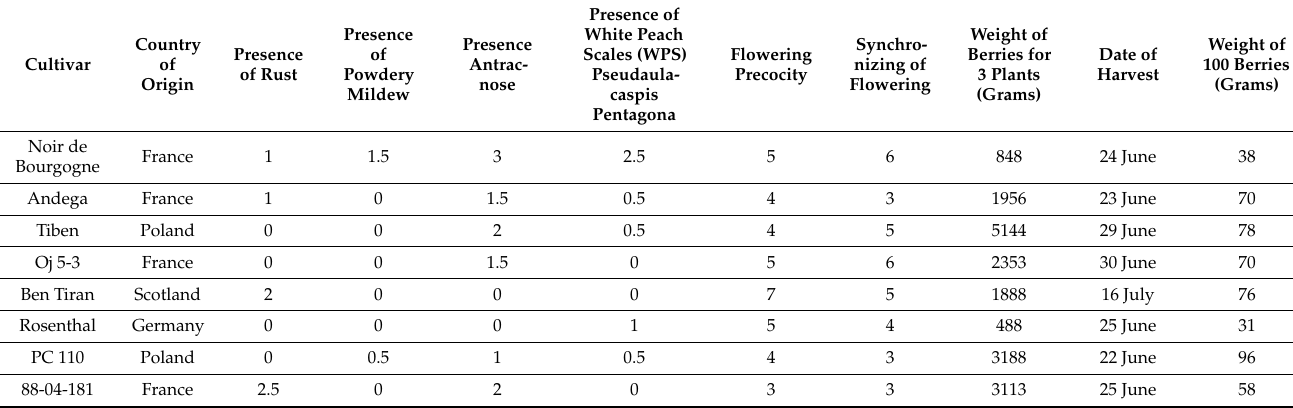
Table 2. Description of cultivars used for